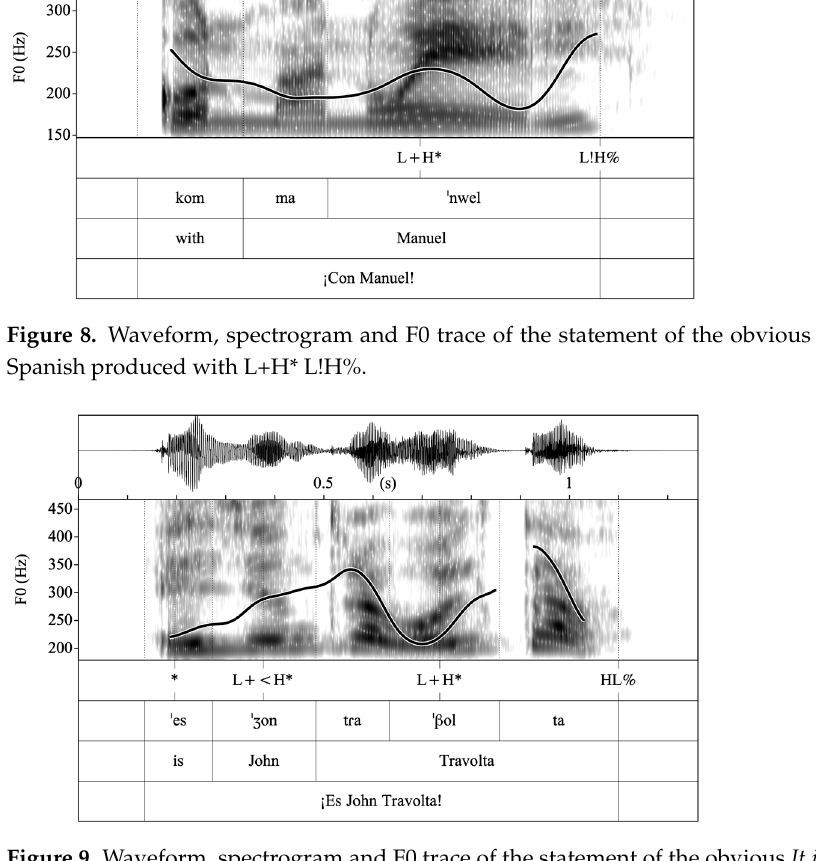
Figure 9. Waveform, spectrogram and F0 trace of the statement of the obvious It is John Travolta! in L1 Spanish produced with L+H* HL%.